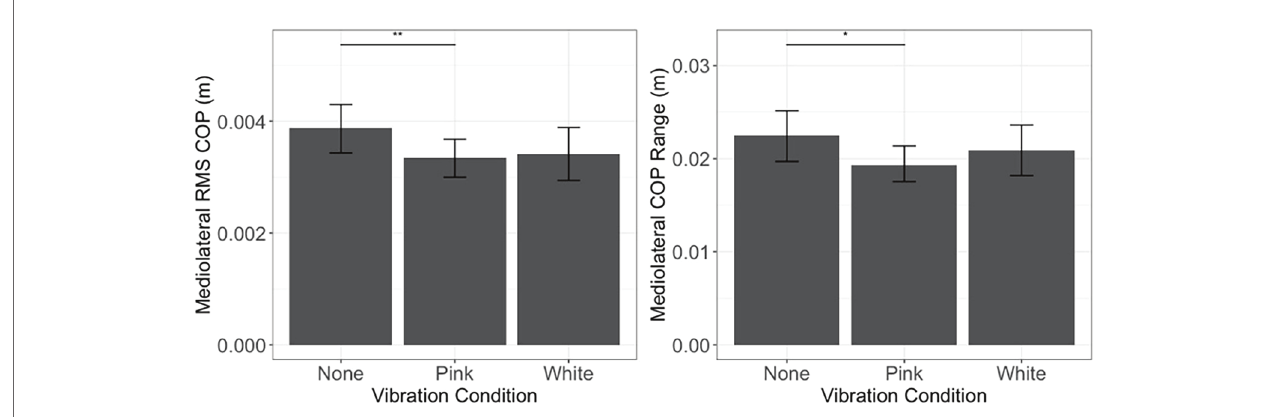
FIGURE 5 | Postural control during quiet standing. Mediolateral COP root-mean-square (RMS; left) and range (right) during quiet standing as a function of vibration condition. Error bars reflect 95% confidence intervals. Range and RMS were height normalized. ** p < 0.01 and * p < 0.05. No differences were observed between light touch threshold groups, and no interactions were observed with respect to these groups. Hence, means and confidence intervals depicted here collapse across light touch